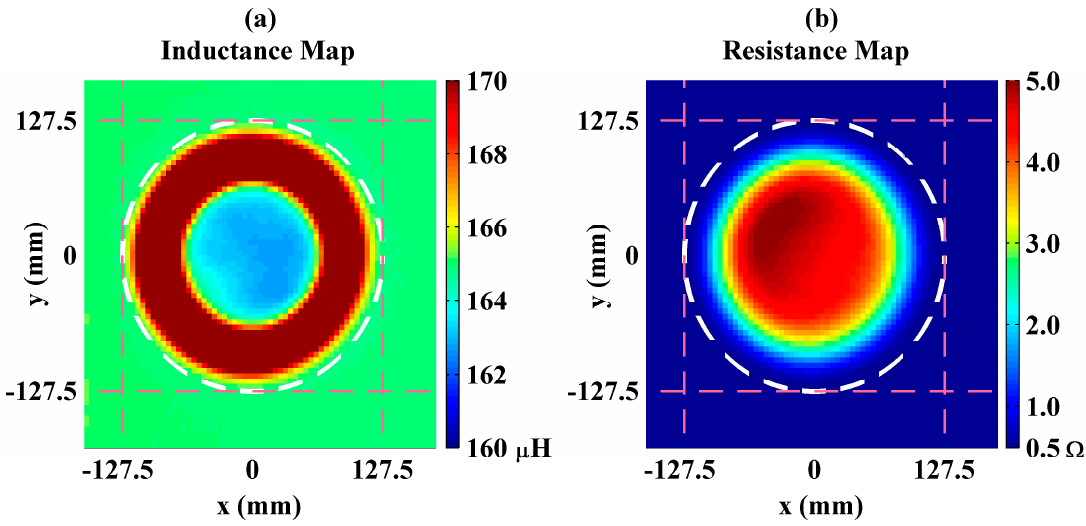
Figure 3. Measured inductance ( a ) and resistance ( b ) maps for the system where the coil is loaded by the steel plate as a function of its lateral position at a horizontal plane 8 mm above the coil. Here, the coil is centered at the (0,0) origin. In addition, the white dash circles represent the points where the coil and the plate projections are tangential. End points of the circles are pointed out with pink ticks at − 127.5 mm and 127.5 mm on the x and y axis.